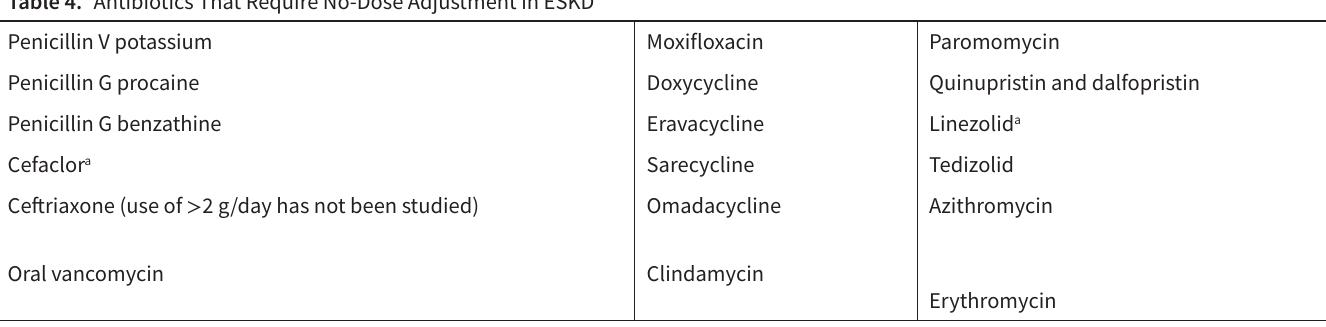
Table 4. Antibiotics That Require No-Dose Adjustment in ESKD Penicillin V